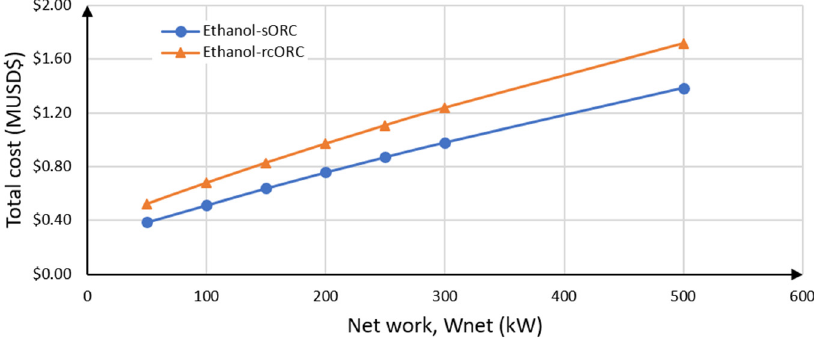
Figure 15. Total capital costs against net work (Ethanol sORC versus rcORC).